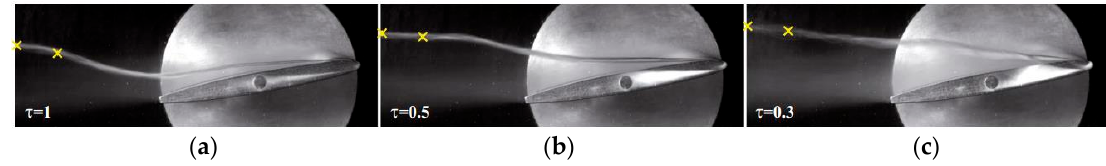
Figure 7. TLV Cavitation visualizations during 11 ms for three tip clearances. The two crosses are the locations z/c = 1 and 1.2 [14]. ( a ) τ = 1; ( b ) τ = 0.5; ( c ) τ = 0.3.